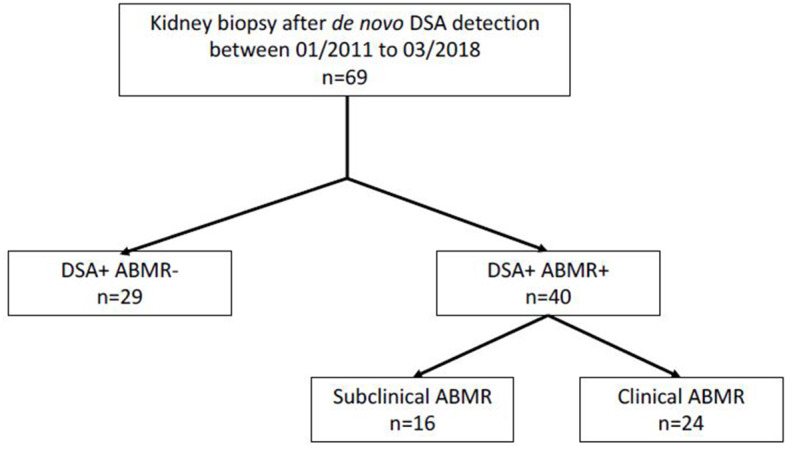
Study flow chart.